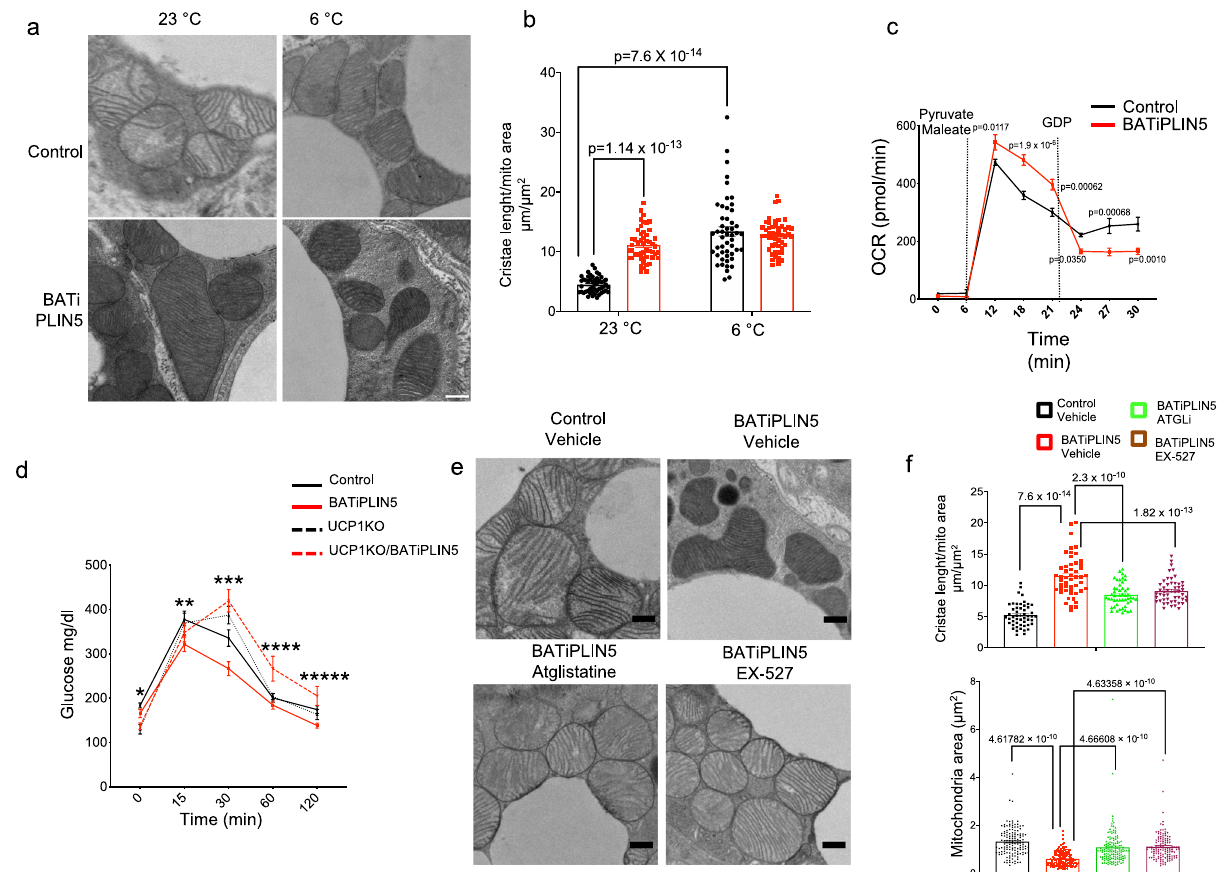
Fig. 6 PLIN5 overexpression in brown adipose tissue increases mitochondrial cristae packing and UCP1-dependent mitochondrial respiratory function. a Representative electron microscopy (EM) images of BAT from Control or BATiPLIN5 mice housed at 23 °C or exposed at 6 °C for 16 h. Scale bar = 0.5 μ m. b Quanti fi cation of total mitochondria cristae length normalized to mitochondrial area in BAT from Control or BATiPLIN5 mice housed at 23 °C or exposed at 6 °C for 16 h. n = 50 mitochondria/group. c Oxygen consumption rate (OCR) from BAT mitochondria isolated from Control or BATiPLIN5 mice housed at 23 °C after sequential injection of pyruvate/maleate and GDP. n = 3 mice per group. d Oral glucose tolerance test comparing Control ( n = 14), BATiPLIN5 ( n = 11), UCP1KO ( n = 6), and UCP1KO/BATiPLIN5 mice ( n = 8). e Representative electron microscopy (EM) images of BAT from Control or BATiPLIN5 mice housed at 23 °C and treated with Vehicle or Atglistatine or Ex-527. f Quanti fi cation of total mitochondria cristae length normalized to mitochondrial area in BAT from Control or BATiPLIN5 mice housed at 23 °C and treated with Vehicle or Atglistatine or Ex-527. n = 50. Values are mean ± s.e.m. For b , statistical analysis was performed using two-way ANOVA followed by Tukey posttest. P values are shown in fi gure. For c , statistical analysis was performed using unpaired two-sided Student ’ s t test. For d , statistical analysis was performed using two-way ANOVA followed by Tukey posttest. P values as follows, *time 0: Control vs UCP1KO p = 0.0217, Control vs. UCP1KO/BATiPLIN5 p = 0.0276, **time 15: Control vs. BATiPLIN5 p = 0.0037, BATiPLIN5 vs. UCP1KO p = 0.0472, ***time 30: Control vs. BATiPLIN5 p = 0.0003, Control vs. UCP1KO p = 0.0261, Control vs. UCP1KO/BATiPLIN5 p = 0.00009, BATiPLIN5 vs. UCP1KO p = 0.000001, BATiPLIN5 vs. UCP1KO/BATiPLIN5 p = 0.00000000006, ****time 60: Control vs. UCP1KO/BATiPLIN5 p = 0.0019, BATiPLIN5 vs. UCP1KO/BATiPLIN5 p = 0.0002, UCP1KO vs. UCP1KO/BATiPLIN5 p = 0.0148, *****time 120: BATiPLIN5 vs. UCP1KO/ BATiPLI5 p = 0.0026. For f , statistical analysis was performed using one-way ANOVA followed by Tukey posttest. P values are shown in fi gure. Source data are provided as a Source data fi